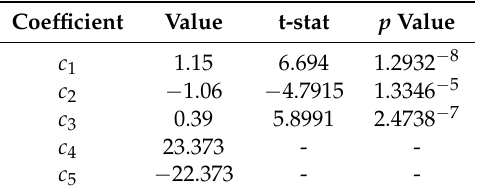
Table 3. Values assumed by the coefficients of (3), together with the values of t-statistics and p -values for the polynomial ones ( c 1 , c 2 , c 3